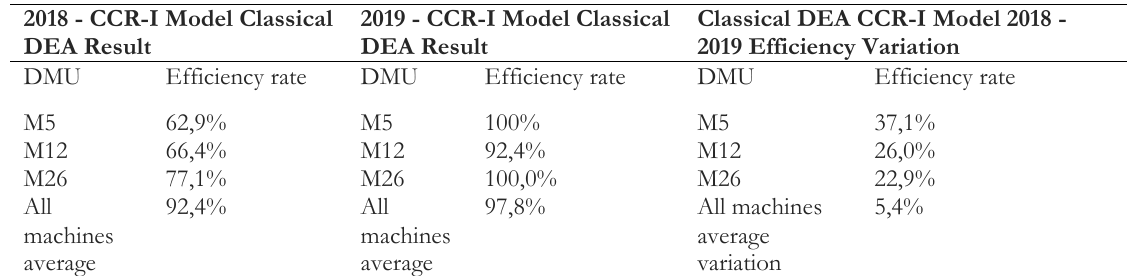
Table 2. CCR – input-oriented classical DEA results and efficiency